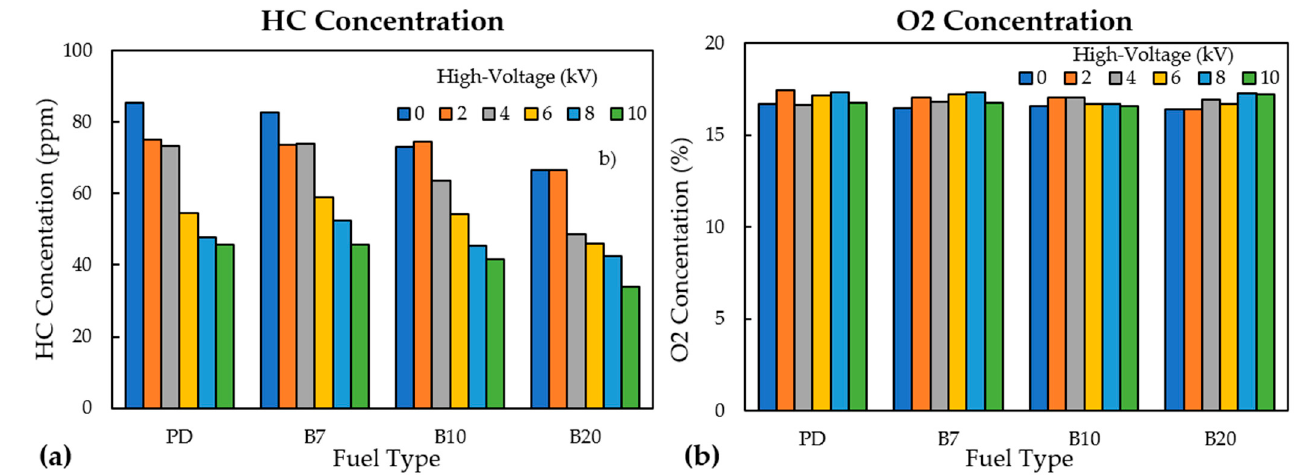
Figure 4. Effect of NTP on HC concentrations ( a ) and Oxygen concentration ( b ) at an engine speed of 2000 rpm and IMEP 6 bar.